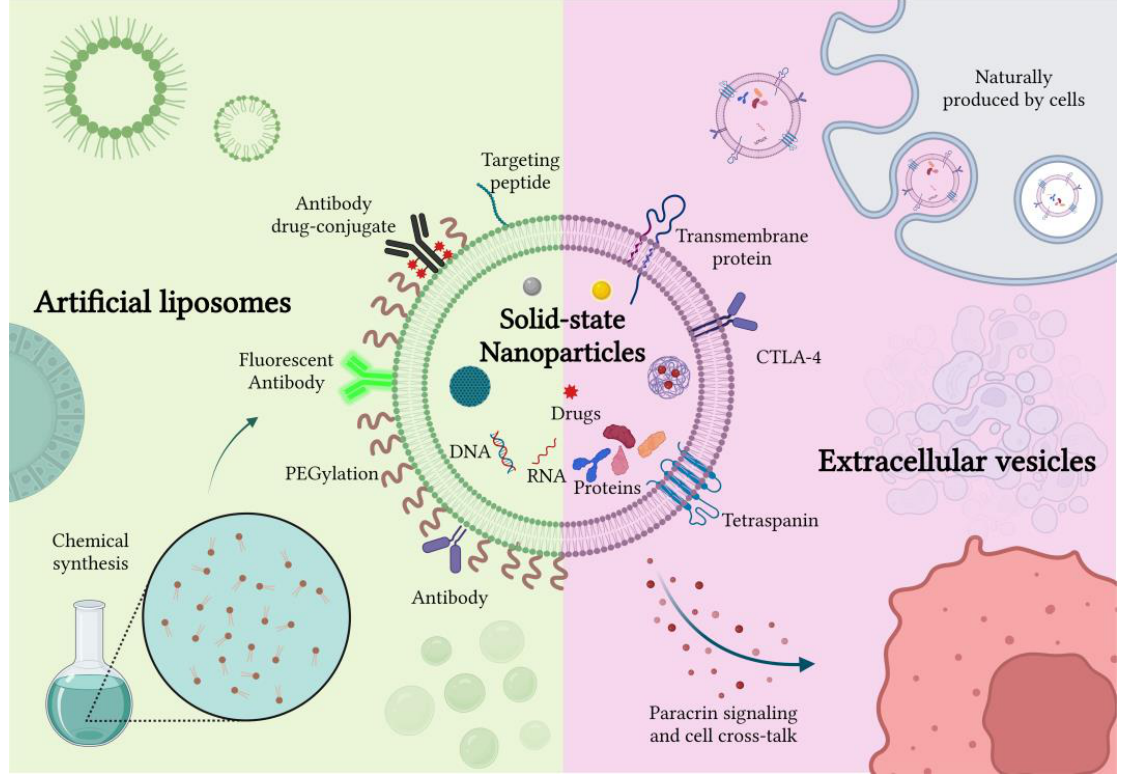
Figure 1. Schematic representation of artificial and naturally derived smart coatings for solid-state nanoparticles. Created with BioRender.com, accessed on 26 October 2022.